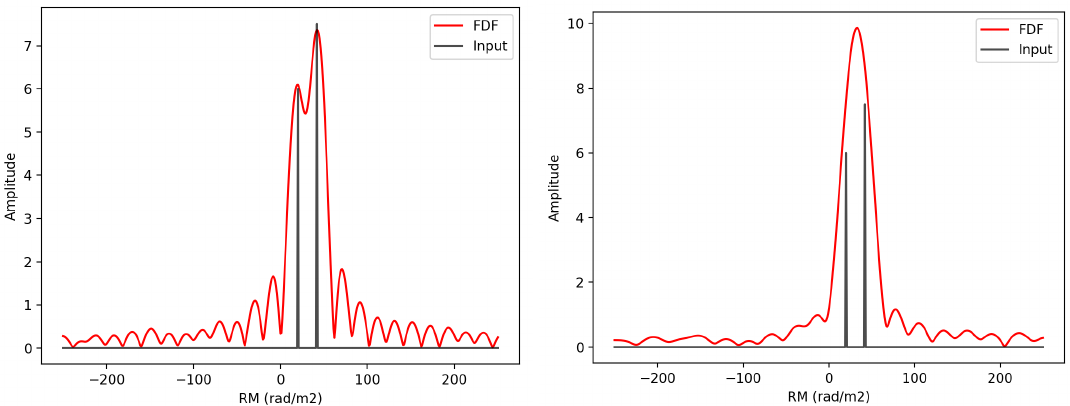
Figure 1. Examples of the results of the rotation measure (RM) Synthesis. The left and right figures show the results for the model d 2 using the frequency band case I and case II,